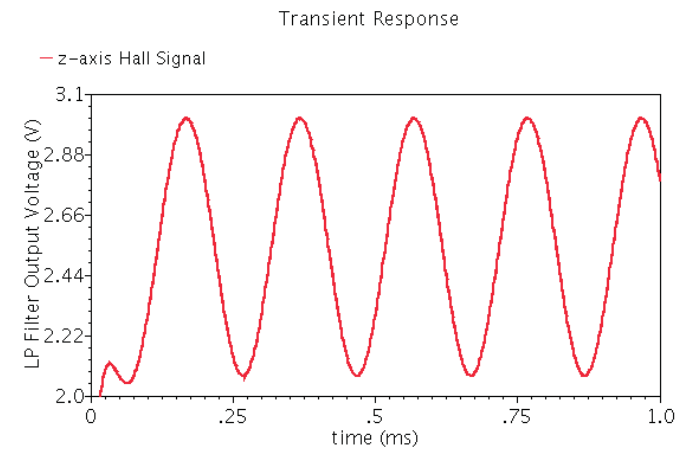
Figure 9. Transient output waveform of low-pass filter of the linear Hall sensor microsystem.